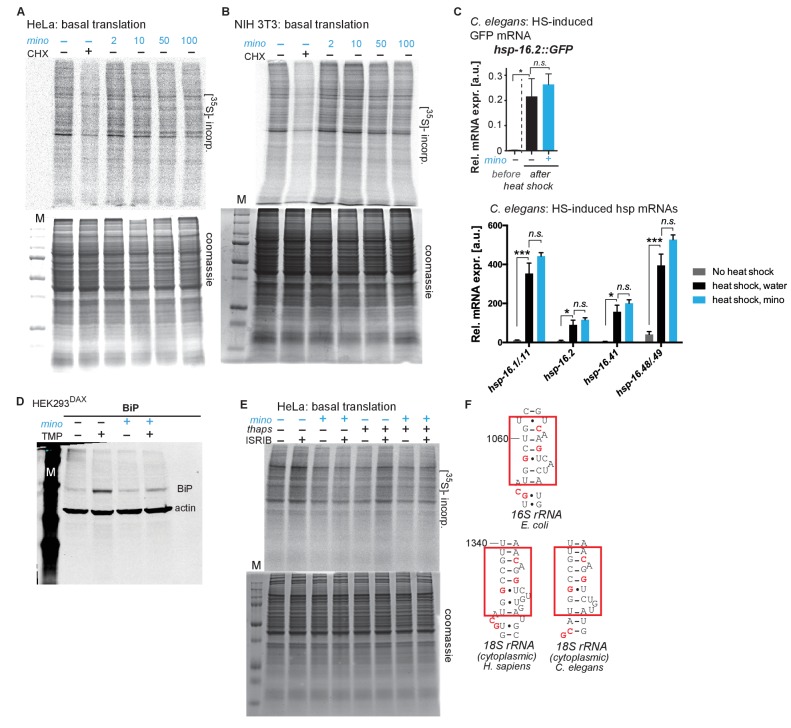
Minocycline suppresses 35S incorporation in multiple paradigms.(A) Full gels shown from Figure 4A. Autoradiograph (top) monitoring 35S incorporation of HeLa cells treated with cycloheximide or increasing concentrations of minocycline. Coomassie gel (bottom) shown as loading control. (B) Autoradiograph (top) monitoring 35S incorporation of NIH 3T3 cells treated with cycloheximide or increasing concentrations of minocycline. Coomassie gel (bottom) is shown as a loading control. Total of 3 independent experiments. (C) qRT-PCR quantification of relative GFP mRNA (top) or hsp mRNAs (bottom) expression from untreated or minocycline-treated (100 μM) hsp-16.2p::GFP C. elegans before and after a 1.5 hr, 35°C heat shock. While heat shock fails to induce GFP fluorescence in hsp-16.2p::GFP reporter animals in the presence of minocycline (Figure 2B,C), it still induces the GFP mRNA, revealing the effect of minocycline on translation. Significance determined by the Mann-Whitney Student's t test. n = 1500 animals per condition. Total of three independent experiments. (D) Full gel shown from Figure 4E. Immunoblots probing for BiP expression of control or minocycline-treated (100 μM) HEK293DAX cells engineered to allow UPRER activation by trimethoprim treatment (TMP). (E) Full gels shown from Figure 4G. Autoradiograph (top) monitoring 35S incorporation of HeLa cells treated with the ISR inhibitor ISRIB, minocycline, thapsigargin (thaps) and a combination of the three. Coomassie gel (bottom) is shown as a loading control. (F) Comparison of the known tetracycline binding site in helix 34 (h34) of the E. coli 16S rRNA with the 18S rRNA of H. sapiens and C. elegans. Red squares indicate the tetracycline binding region with the interacting residues highlighted in red. Asterisks indicate significance *<0.05, **<0.01, ***<0.001, n.s. not significant.